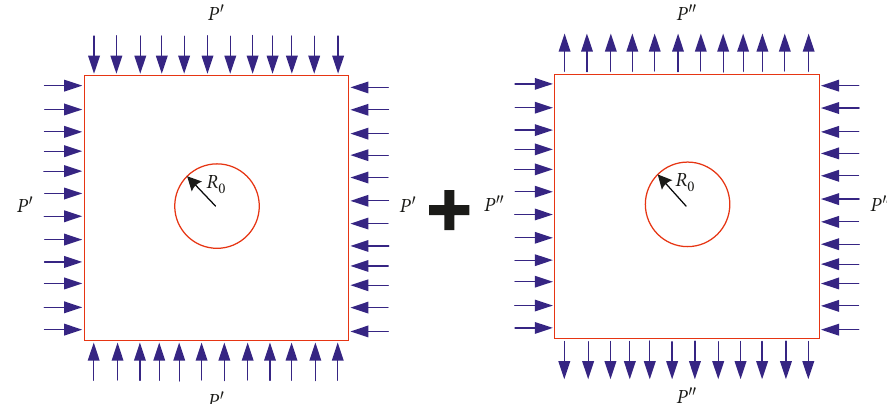
Figure 3: Decomposition of surrounding rock pressure for the roadway: (a) Case I and (b) Case II.